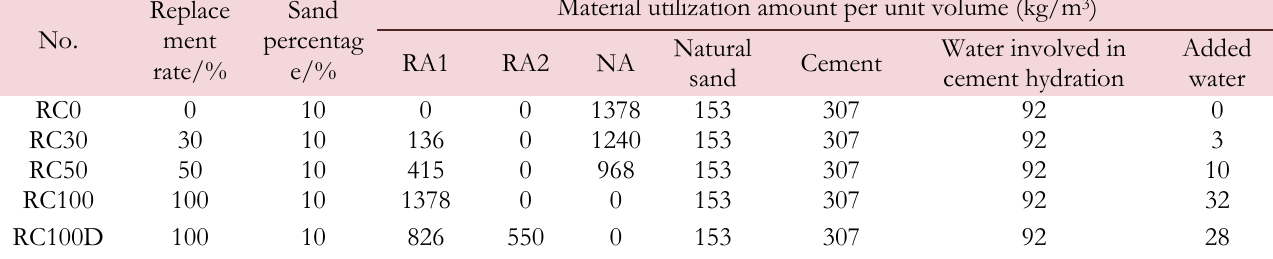
Table 2: Mix proportion of recycled pervious